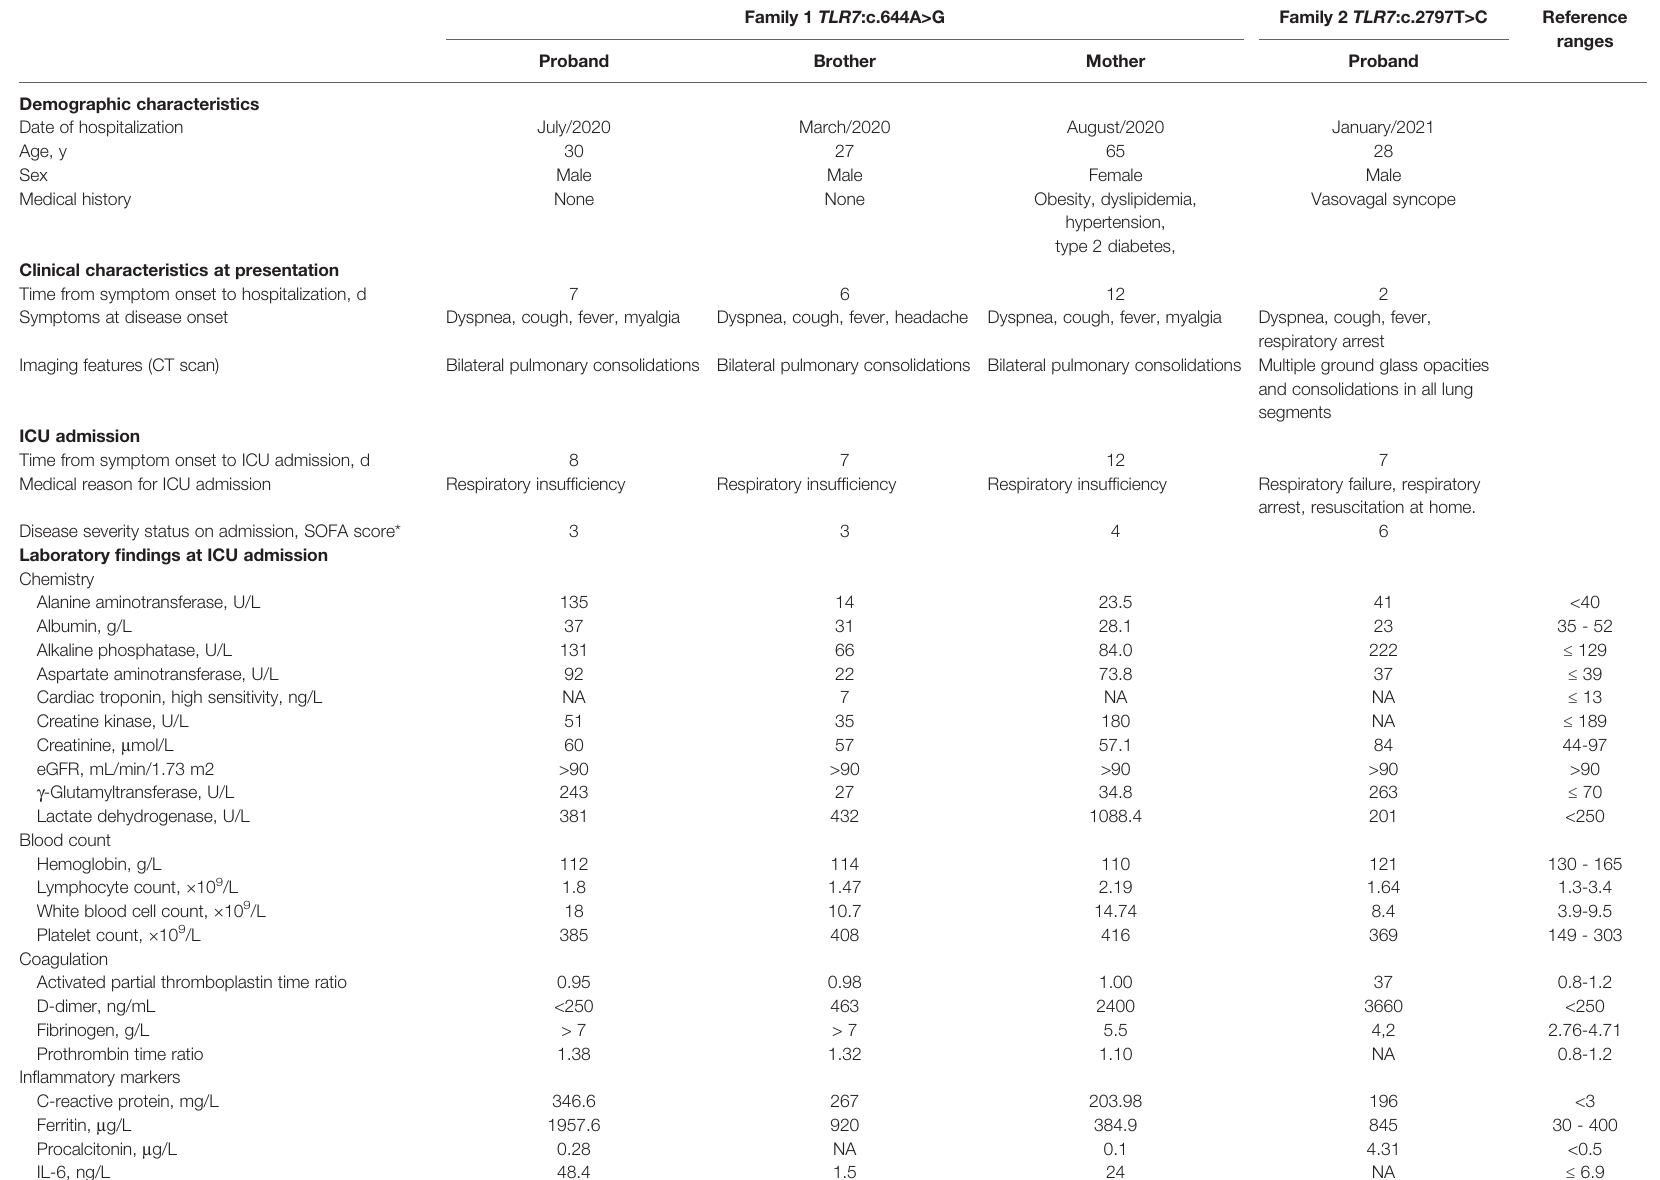
TABLE 2 | Demographic, clinical, laboratory, and radiological fi ndings of investigated